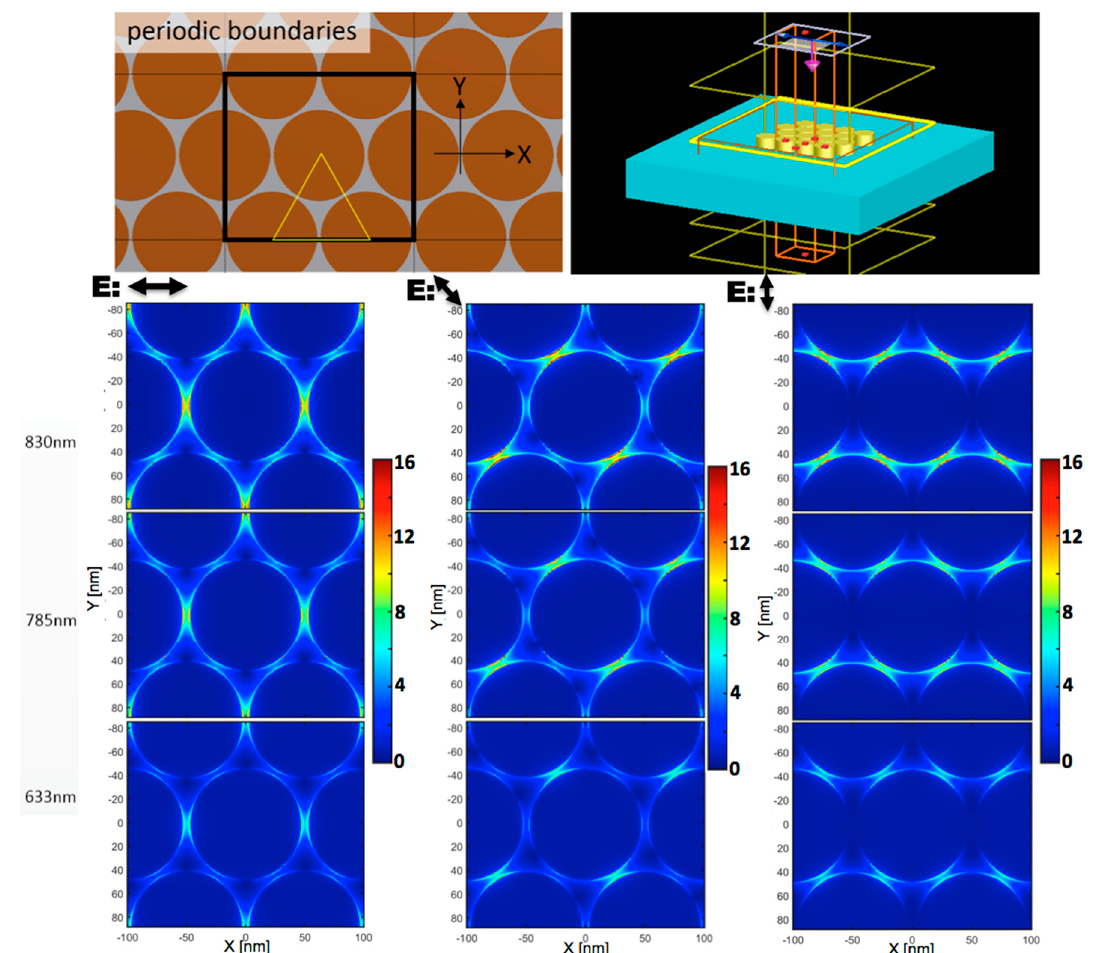
Figure 3. Electromagnetic FDTD simulations of the device. In the upper panels, the design of plasmonic device superimposed by the periodic boundaries (top view) and the whole simulation volume with monitors and source (perspective view). In the bottom panels, the electric field amplitude distribution (normalized to the excitation) obtained at 633, 785, and 830 nm when excited with plane wave, in plane polarized along the short wire interaxis (horizontal), at 60 degrees, and along the long interaxis (vertical).